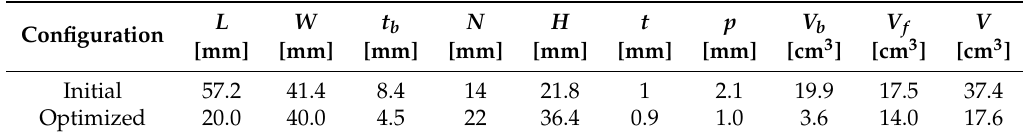
Table 5. Initial and optimized release heat sink